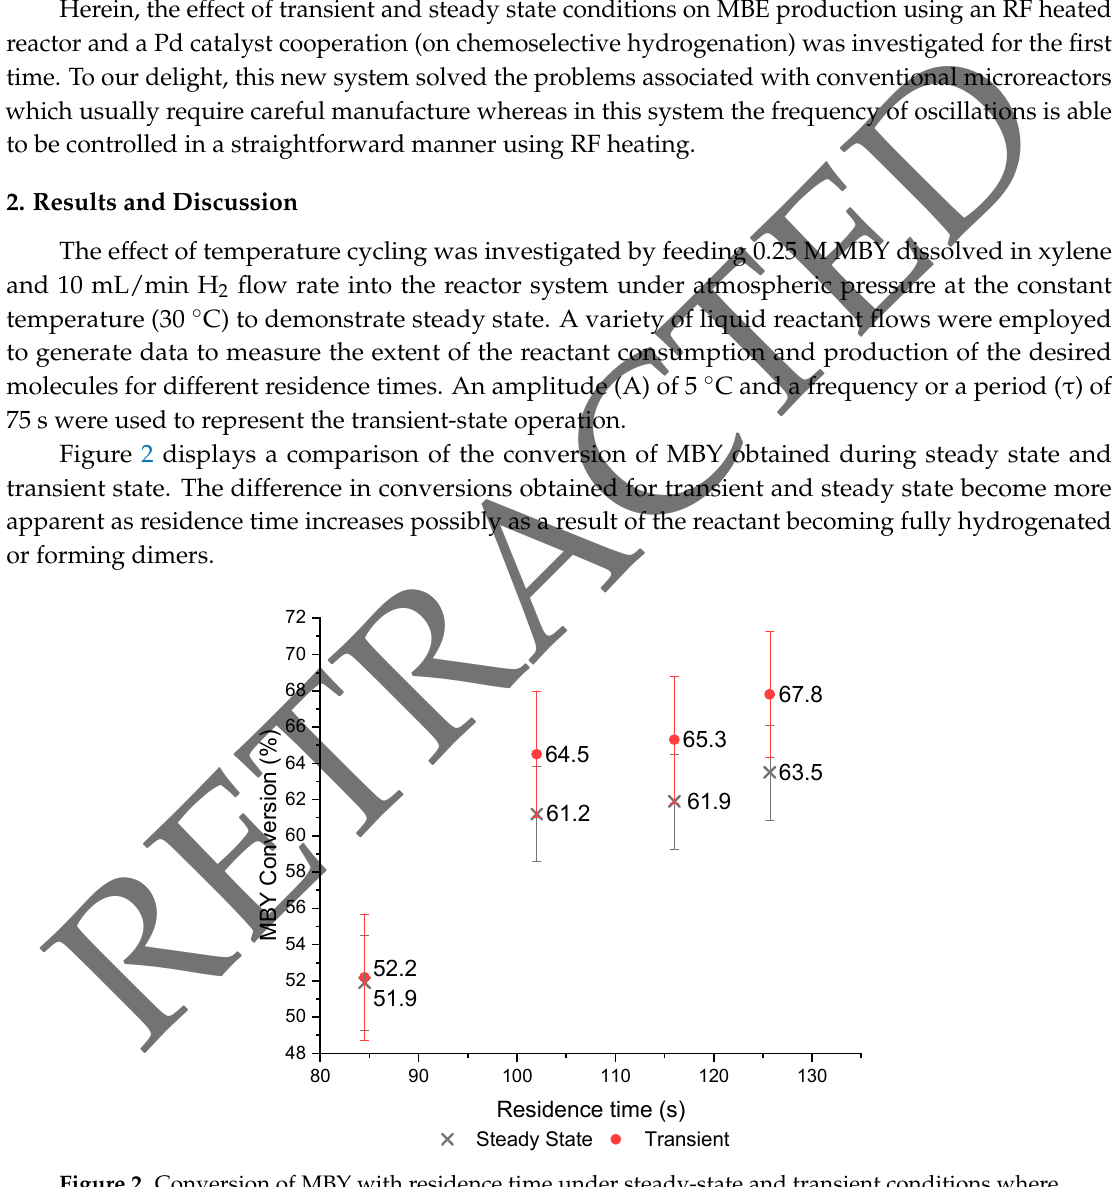
Figure 2. Conversion of MBY with residence time under steady-state and transient conditions where A = 5 ◦ C and τ = 75